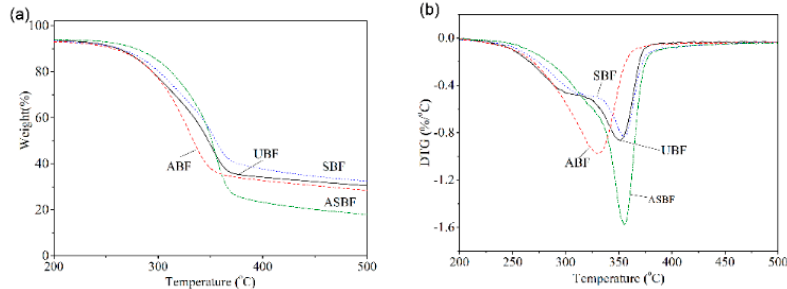
Figure 5. Thermogravimetry (TGA)curves of BF modified by various methods: ( a ) TGA, ( b ) DTG.